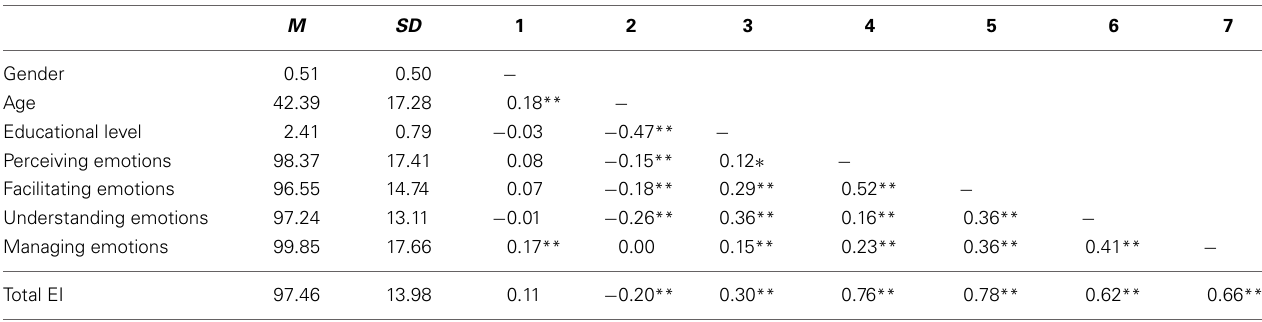
Table 1 | Means, standard deviations, and intercorrelations among